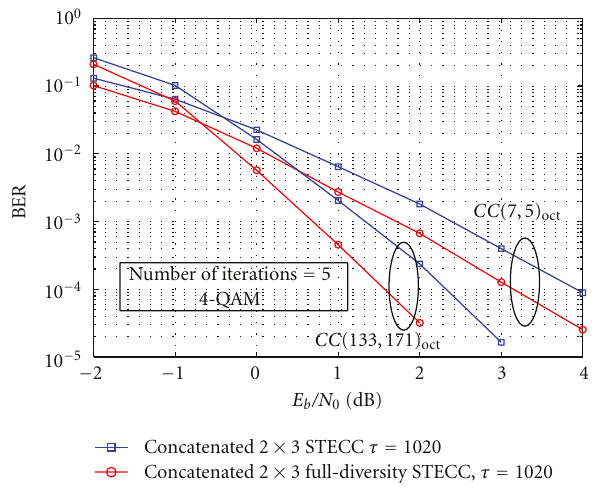
Figure 9: Performance comparison of the concatenated full diver- sity STECC and the concatenated suboptimal-diversity STECC. 3 × 4074 information bits. n r = 2. Outer code: the 7 / 8-rate punctured CC (133,171) oct